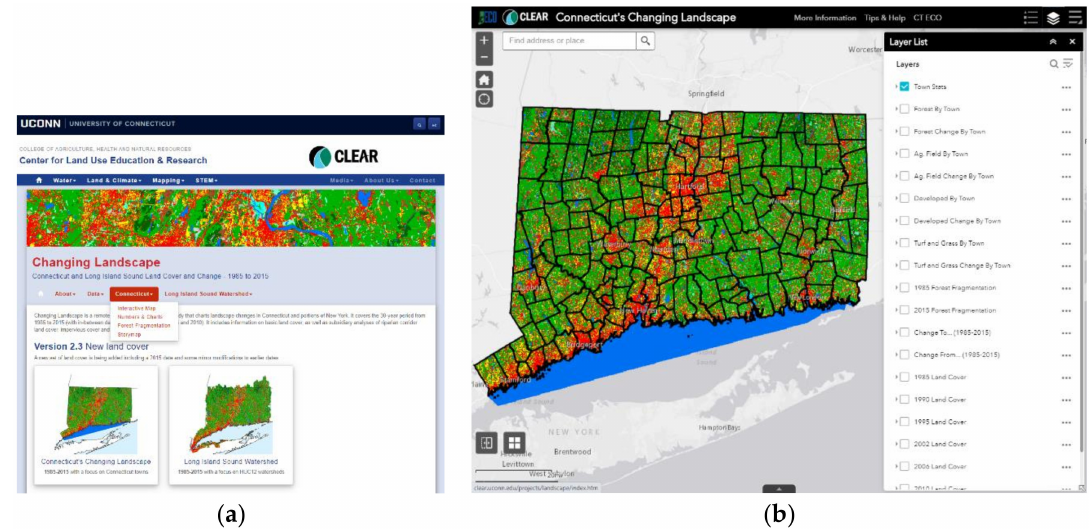
Figure 8. ( a ) The current CCL website home page and ( b ) the current interactive map viewer.